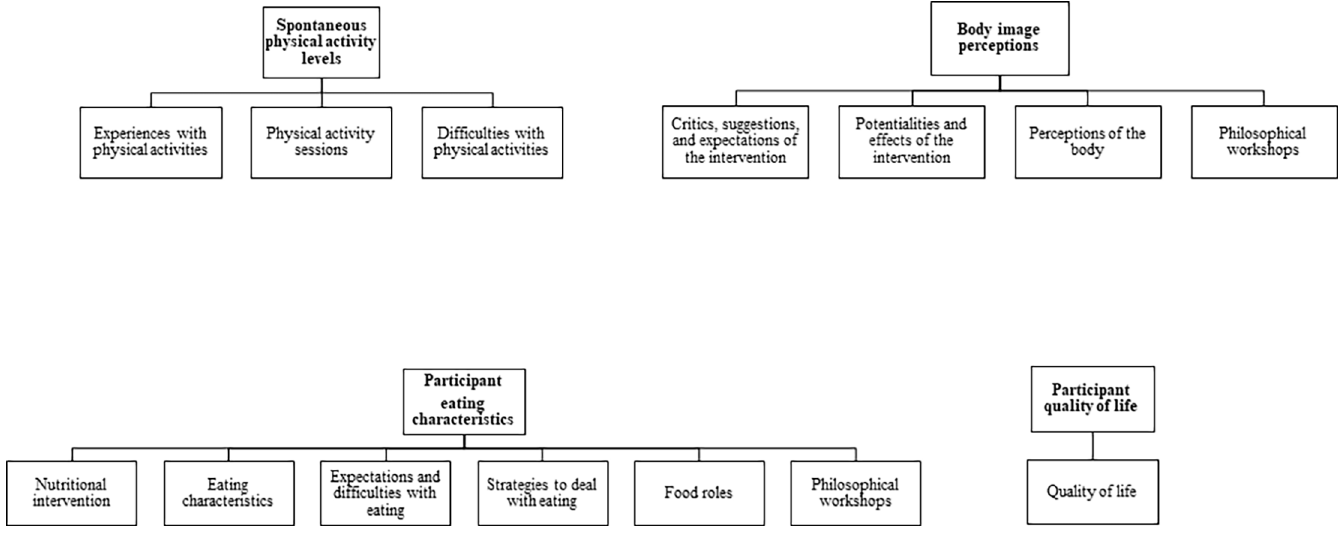
Fig 2. Representation of the codes that composed some of the resultant